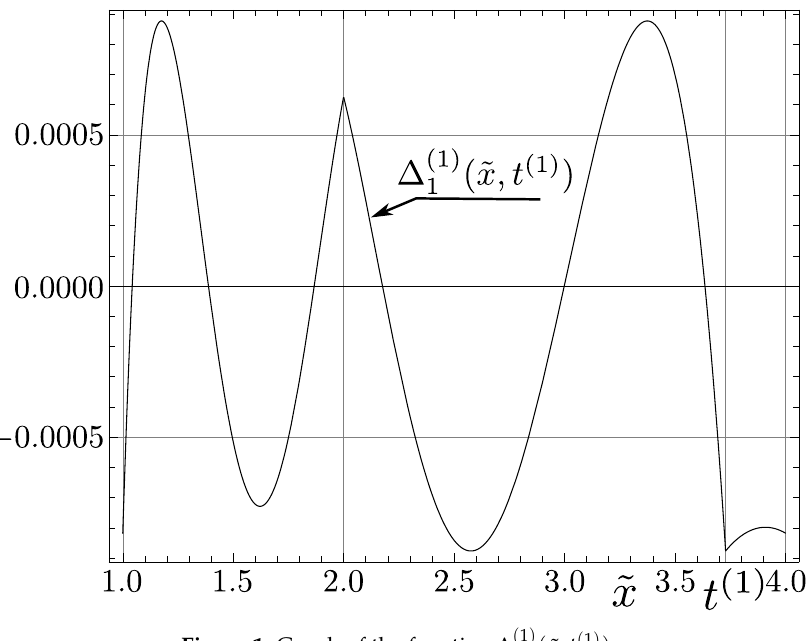
Figure 1. Graph of the function ∆